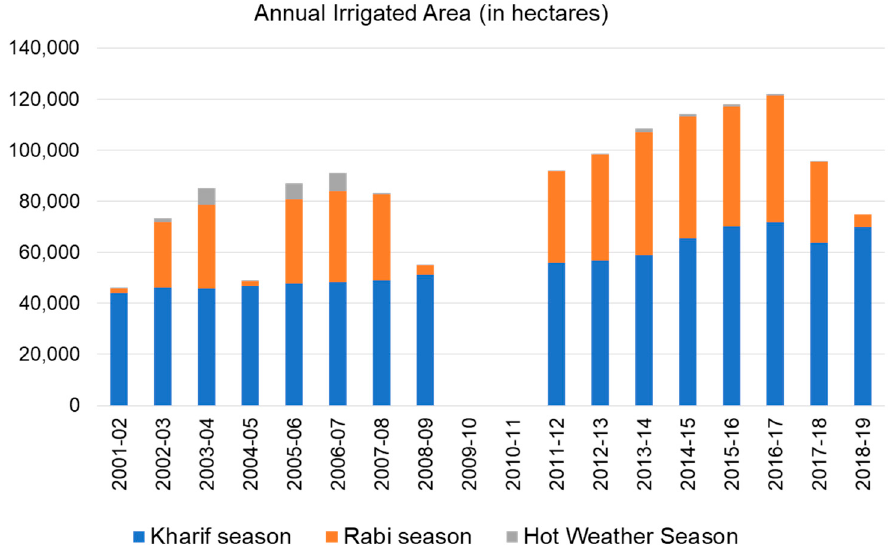
Figure 7. Annual irrigated area (season ‐ wise) from the Pench Project (2001–19). Information source: Reference